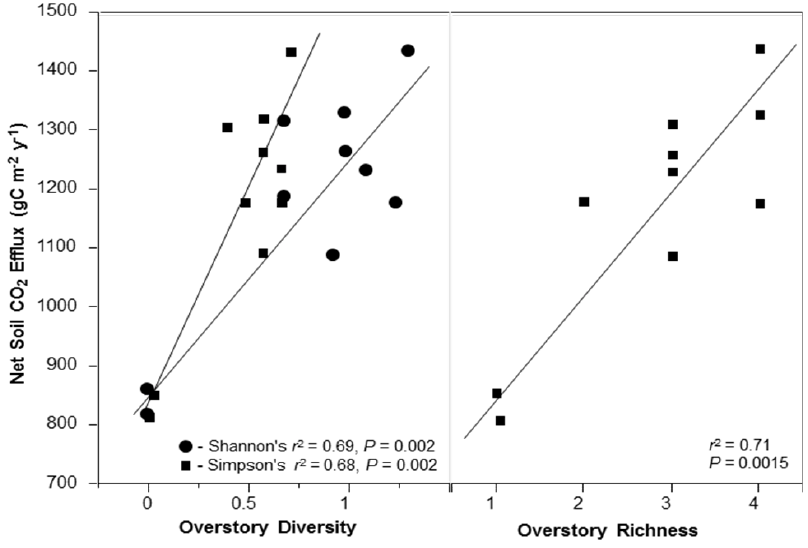
Figure 4. Positive relationships between soil CO efflux and overstory diversity 2 represented by Shannon’s and Simpson’s diversity indices (which includes all 12 overstory species (A) ), and Overstory Richness 5 which includes the five most dominate tree species; P . menziesii, A. macrophyllum , A. rubra , T. heterophylla, and T. plicata (B) ; note that even though five species are represented, maximum species richness in the intensively measured plots was four.